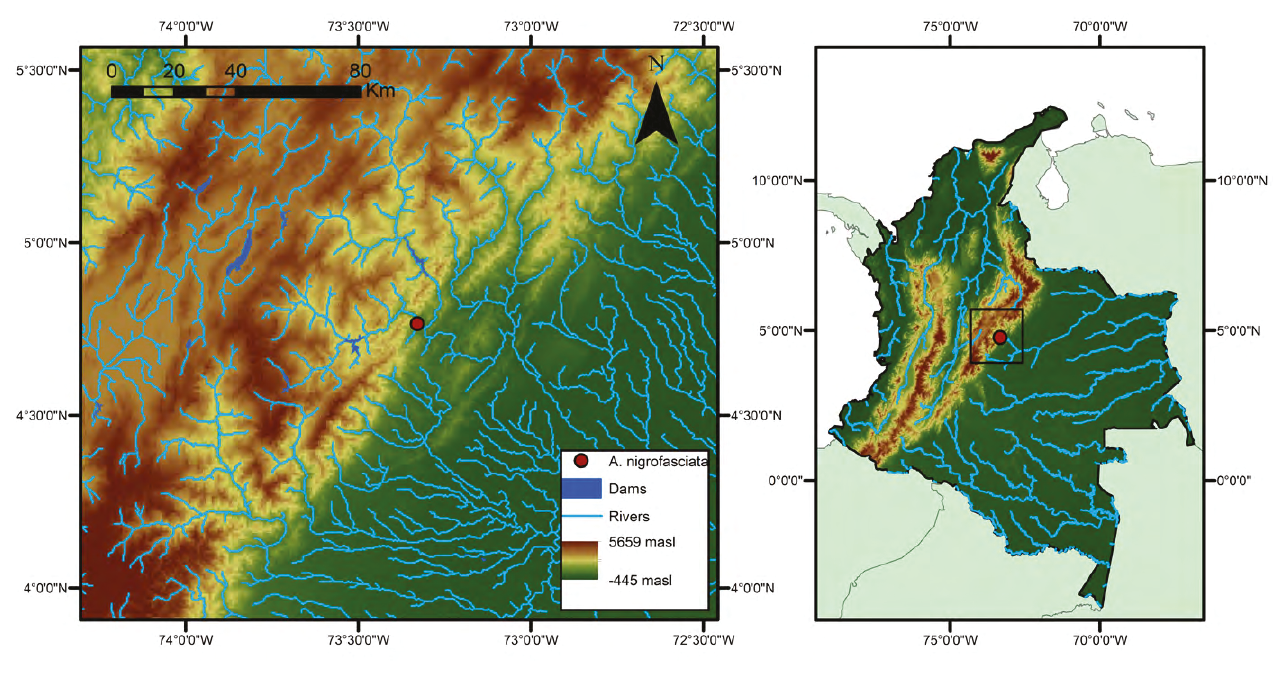
Figure 5: Record of A . nigrofasciata in Colombia. Red circle represents both localities.